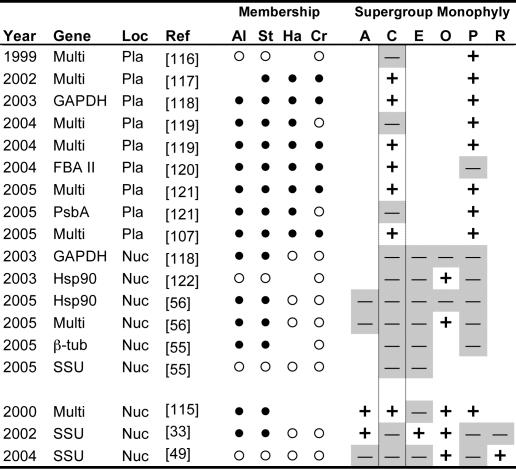
Support for Membership and Supergroup Monophyly from “Chromalveolata”-Targeted Molecular GenealogiesMember taxa: Al, Alveolata; St, Stramenopiles (Heterokonts); Ha, Haptophyta; Cr, Cryptophyceae. Monophyletic “Plantae” from plastid genealogies includes secondarily derived plastids. See Figure 4 for further notes. References cited in this figure are [33,49,55,56,107,108,115–122].Loc, location (genome) from which the gene of interest originated; Pla, plastid genome; Nuc, nuclear genome; Mit, mitochondrial genome.